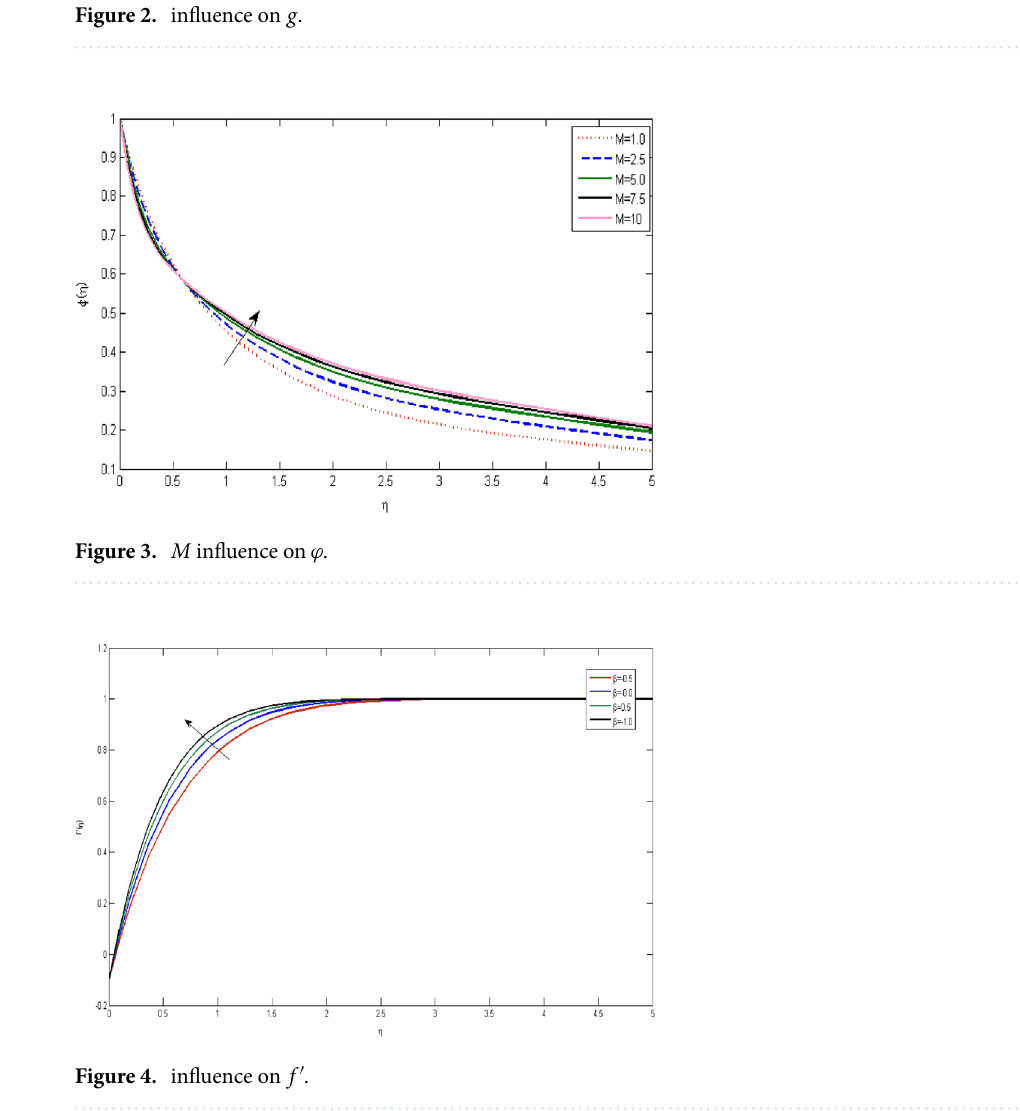
Figure 2. influence on g .